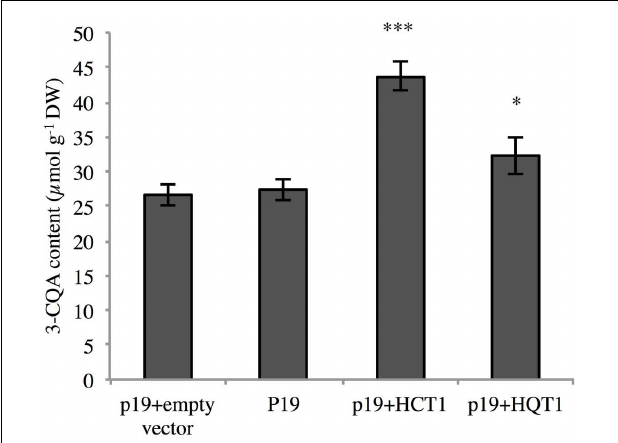
FIGURE 9 | Determination of CQA content in Nicotiana benthamiana transiently transformed leaves. Transformants either carried the pEAQ-HT vector (p19) alone or associated with the empty pB2GW7 vector (p19 + empty vector) or with the pB2GW7-HCT1 vector (p19 + HCT1- or with the pB2GW7-HQT1 vector (p19 + HQT1). The data represent means ± SEM of eight transiently transformed leaves from four independent plants. Statistical differences were highlighted compared to the control p19 + empty vector using one tail Student’s test ( ∗ P < 0.05; ∗∗∗ P <